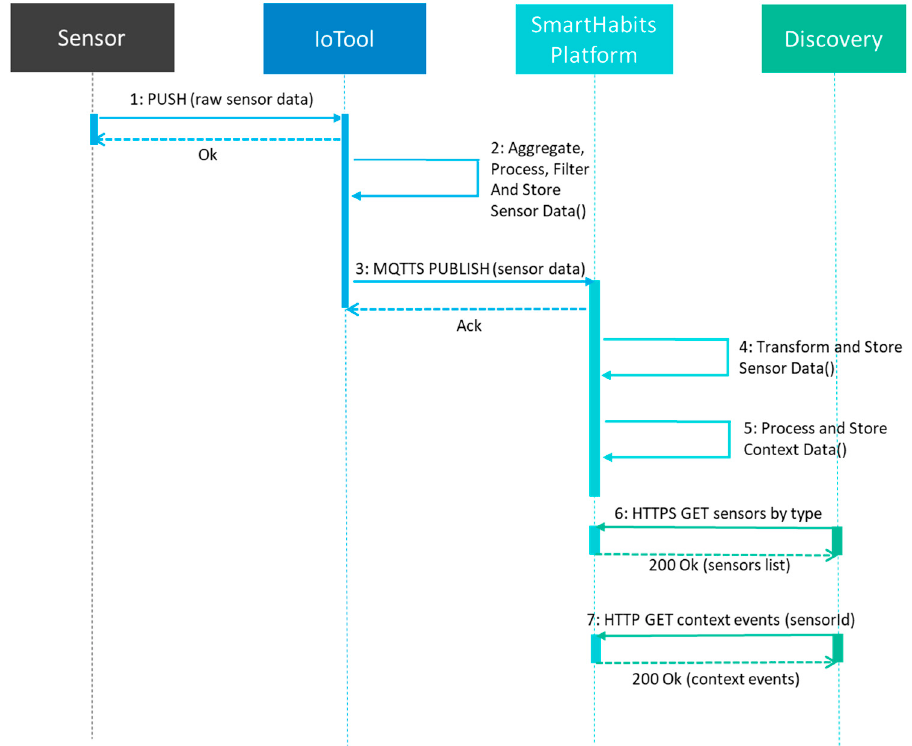
Figure 5. The high-level sensor data flow of the monitoring service.